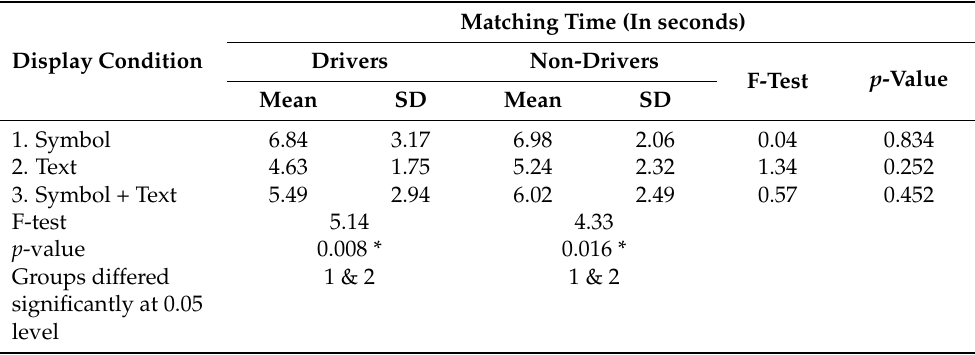
Table 8. Matching time of drivers and nondrivers vs. display